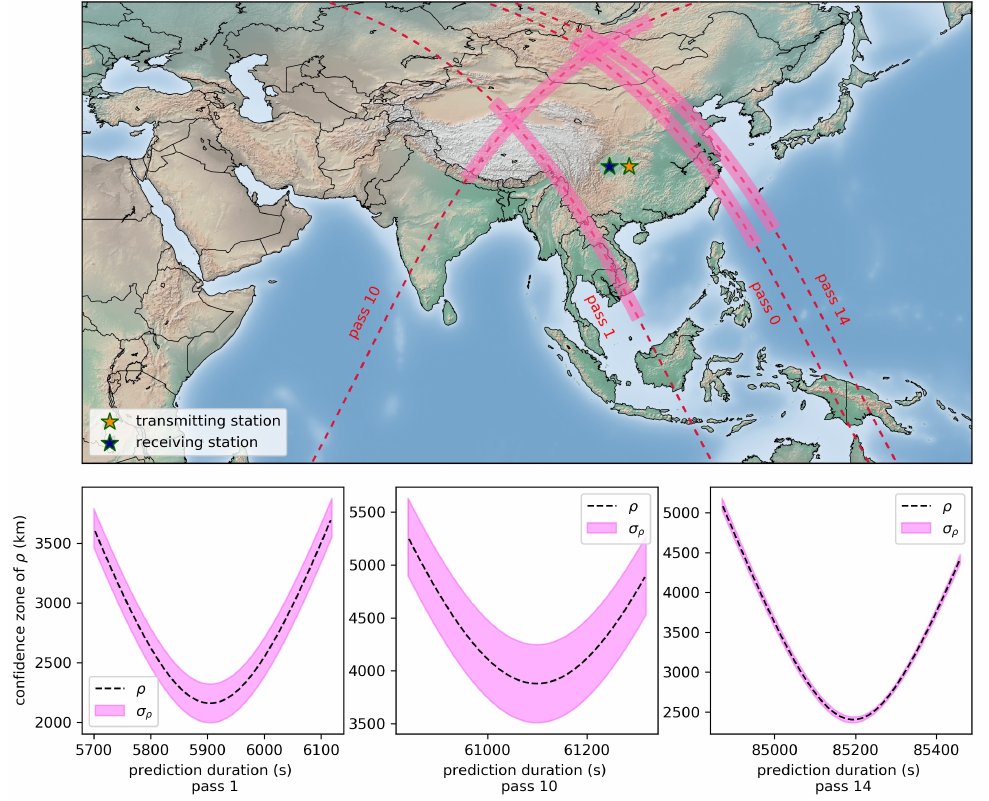
Figure 7. Evolution of ρ and ∆ ρ